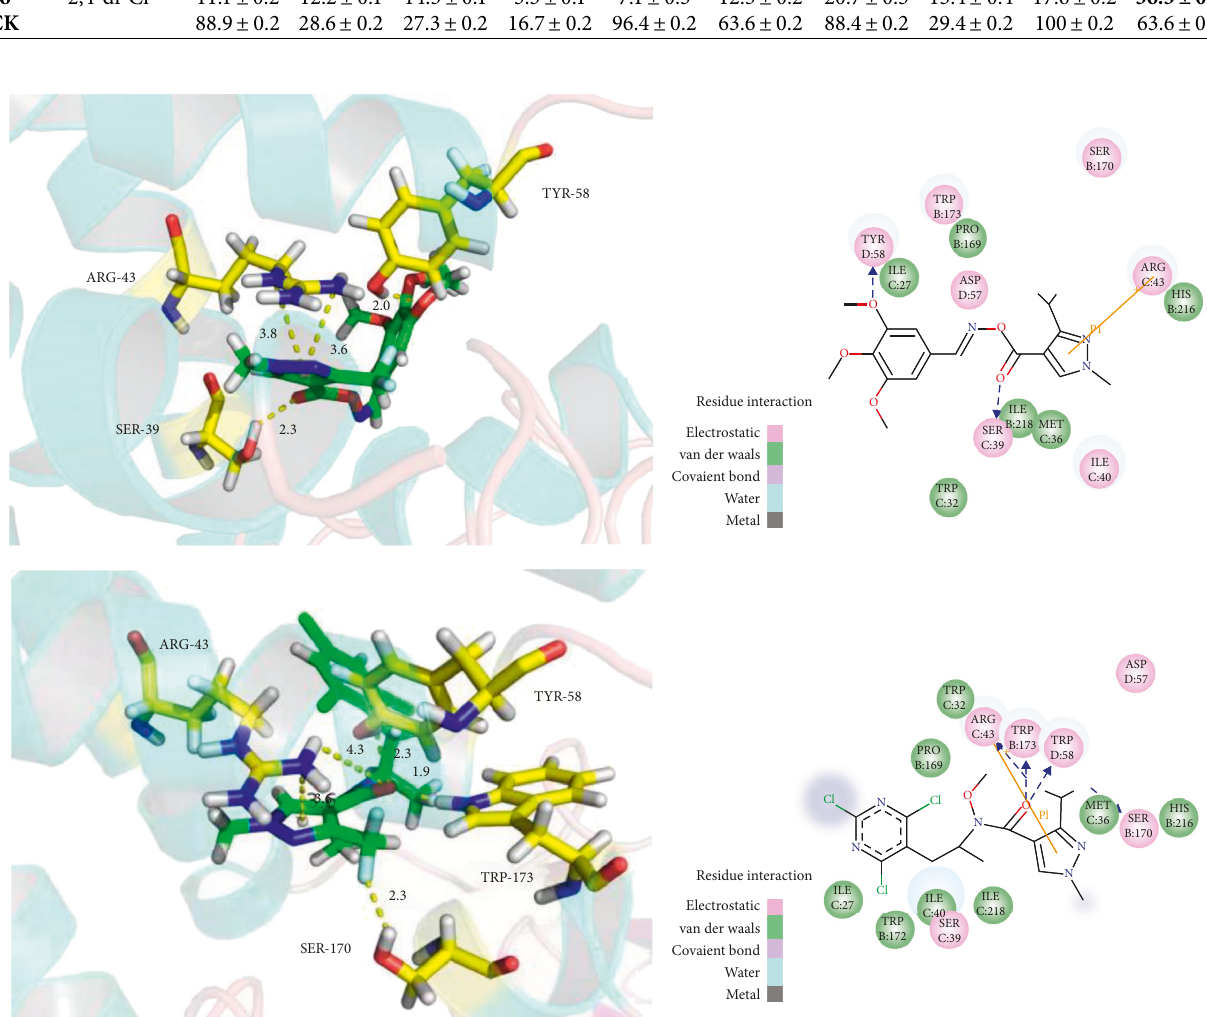
Figure 3: Docking modeling and molecular receptor-ligand interactions of compound 5g (above, left 3D, right 2D) and CK (down, left 3D, right 2D) with SDH.